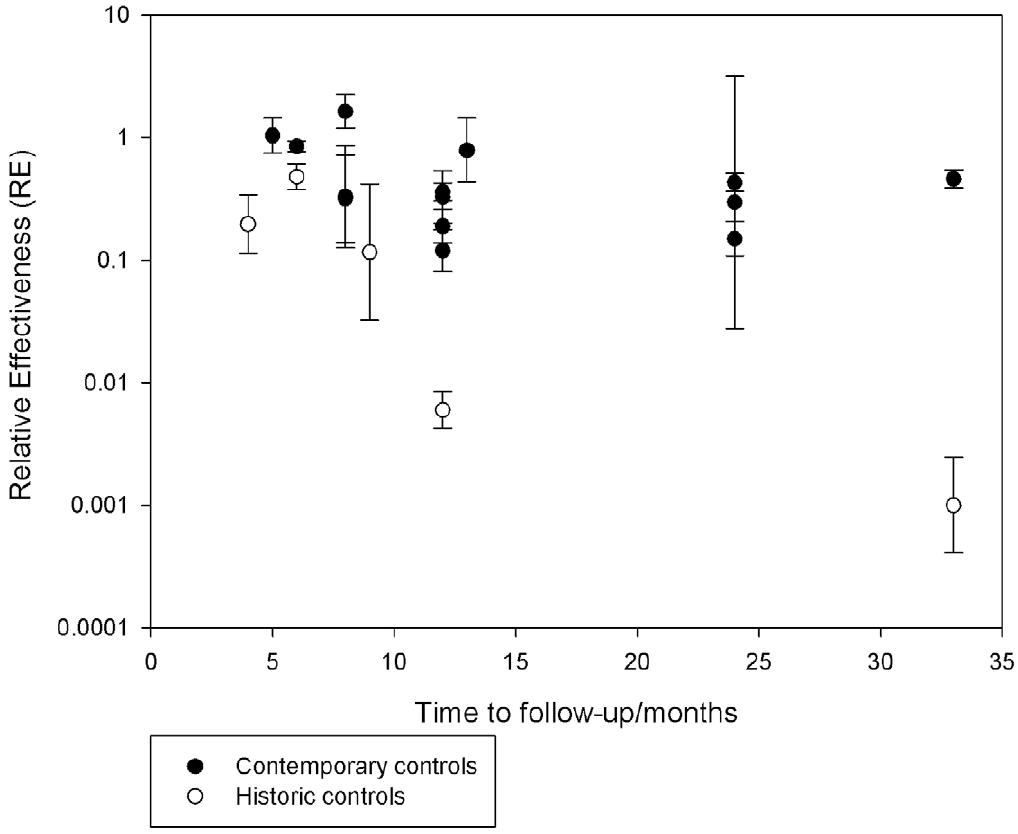
Figure 4. Midpoint of relative effectiveness of studies using by control and by time from intervention to assessment.* Graph only based on 19 studies as follow-up time not given for three studies.